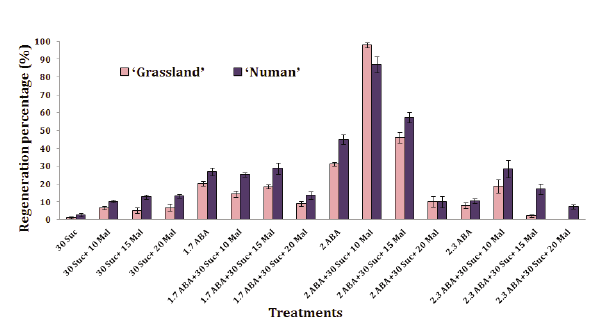
Fig. 2 - Regeneration rates of two cultivars of Lolium perenne L. in combination concentrations of ABA (0, 1.7, 2 and 2.3 mg L -1 ), and maltose (0, 10, 15 and 20 g L -1 Mal) under same concentration of sucrose (30 g -1